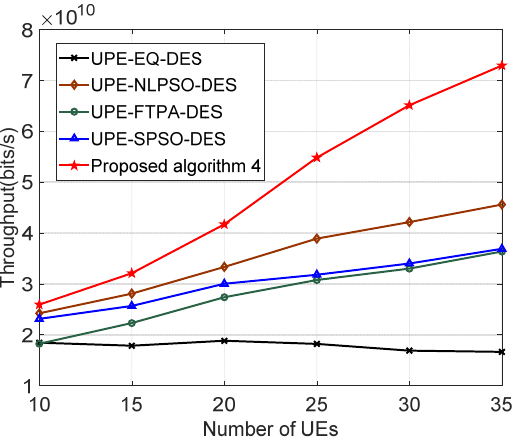
Figure 6. Throughput versus the number of UEs for different joint algorithms.